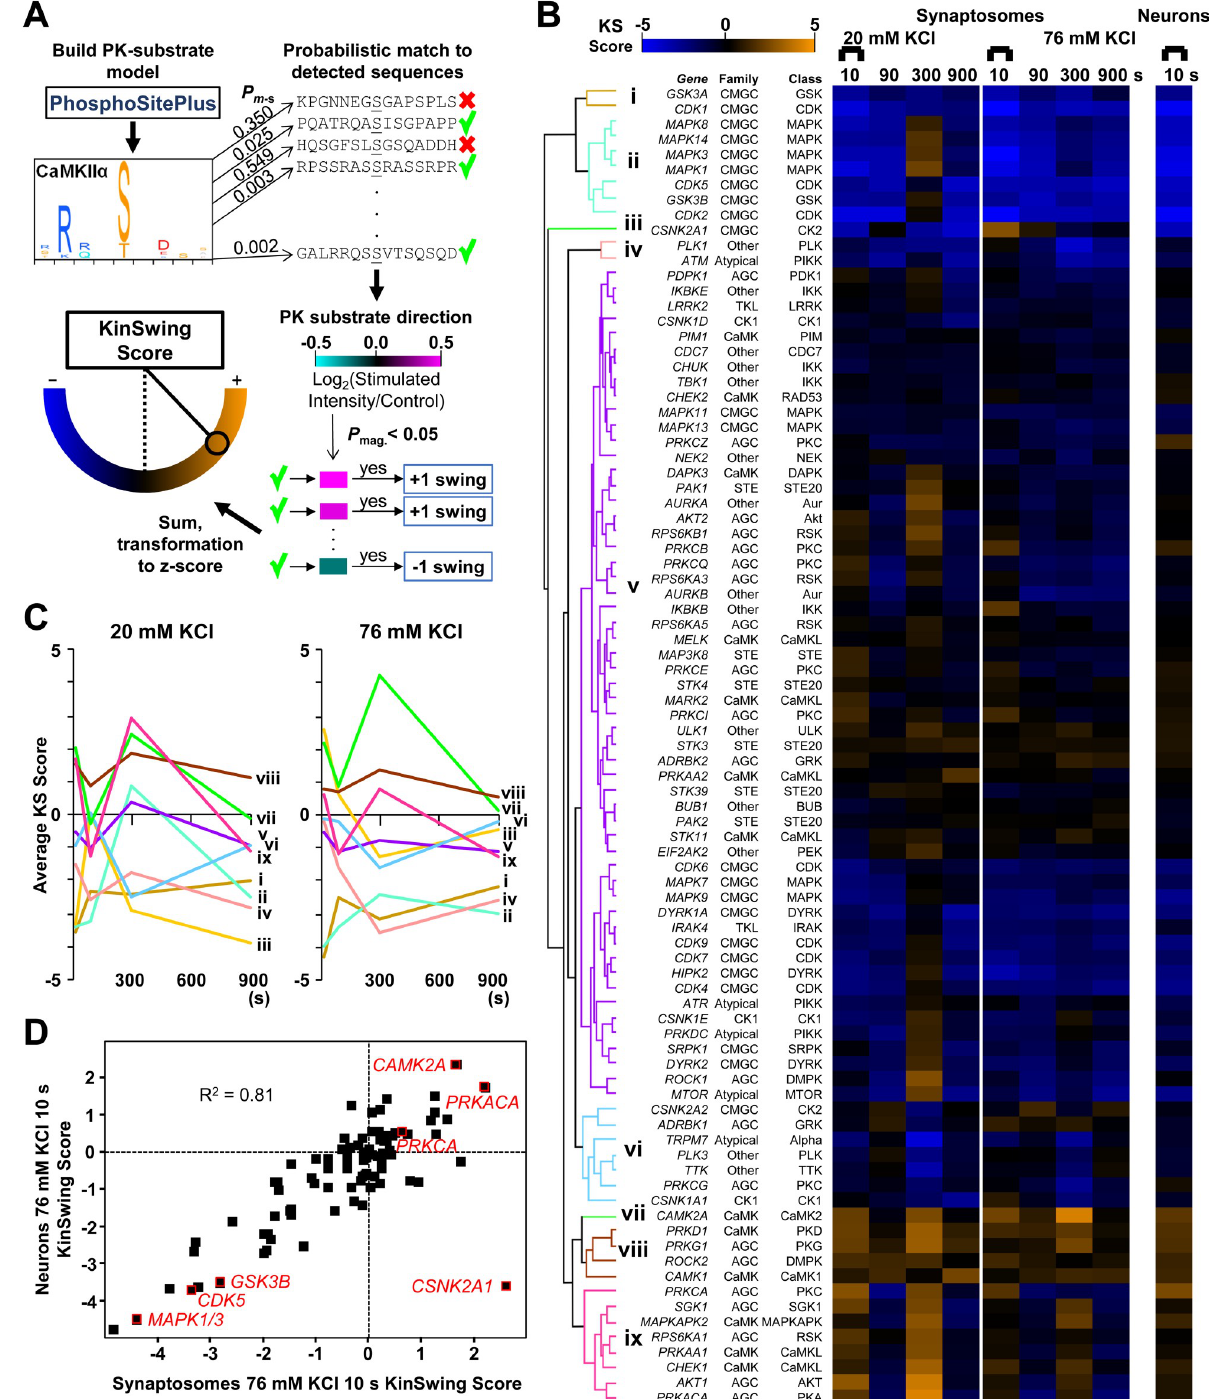
Fig 6. Determination of the inferred protein kinase activity across time using KinSwing. (A) Schematic of the process for generating KS scores. The human data contained in PhosphoSitePlus [33] were used to determine PK substrate motifs for each protein kinase (CaMKII α shown as an example). The probability of a sequence match, P m-s , between the PK substrate motif and the centred sequence of each detected phosphorylation site was calculated. The magnitude of the significantly regulated phosphorylation sites ( P mag. < 0.05) was used to assign positive or negative (+1/ − 1) swing. An overall swing was determined from the sum of swings for the group of probable PK substrates. The swing was transformed to a z-score (KS score) to allow for comparison across time points (see Materials and methods for a detailed description). The process was repeated for each condition and time